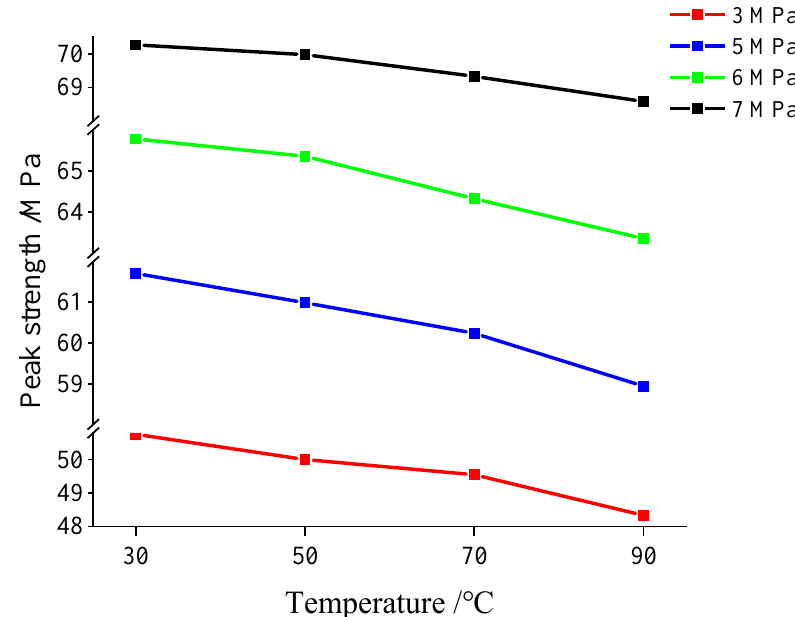
Figure 9. Variation of peak stress with temperature under different confining pressures.